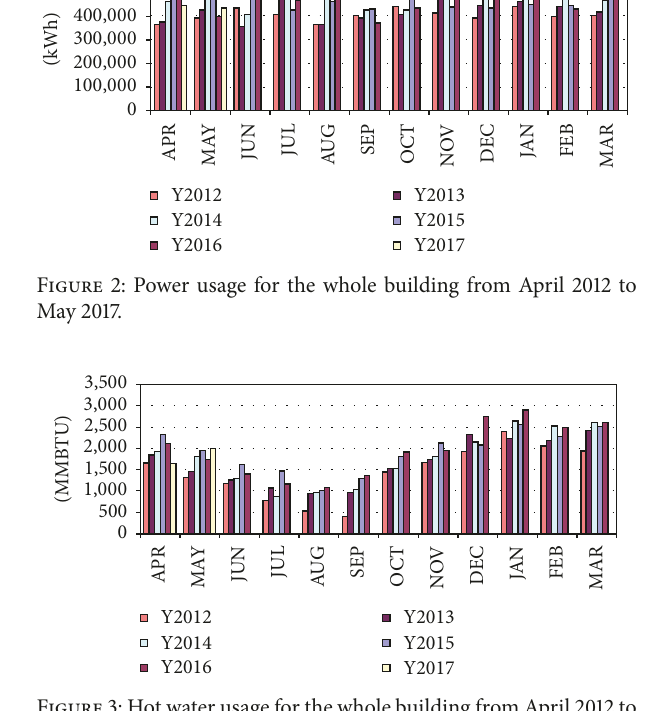
Figure 3: Hot water usage for the whole building from April 2012 to May